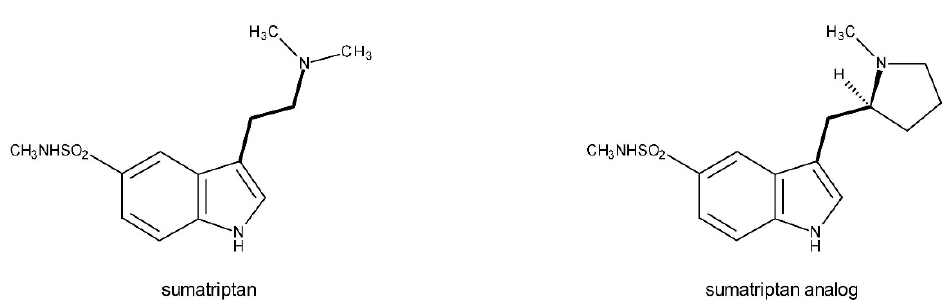
Figure 1. 5-hydroxytryptamine and its selected rigidized analogs I–VII.